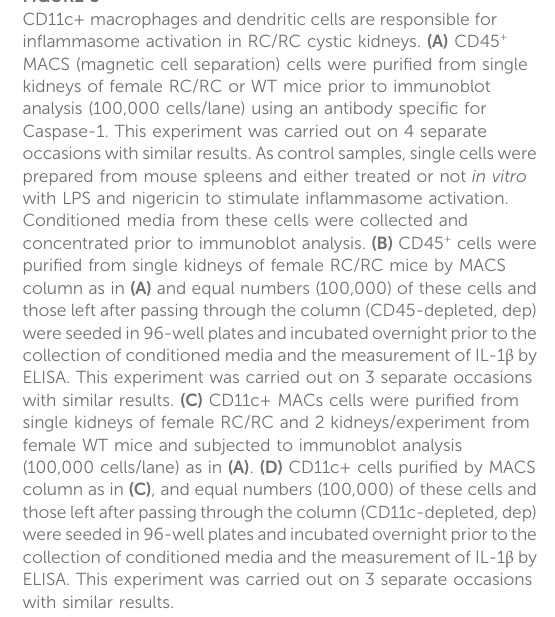
with similar results. (C) CD11c+ MACs cells were puri fi ed from single kidneys of female RC/RC and 2 kidneys/experiment from female WT mice and subjected to immunoblot analysis (100,000 cells/lane) as in (A) . (D) CD11c+ cells puri fi ed by MACS column as in (C) , and equal numbers (100,000) of these cells and